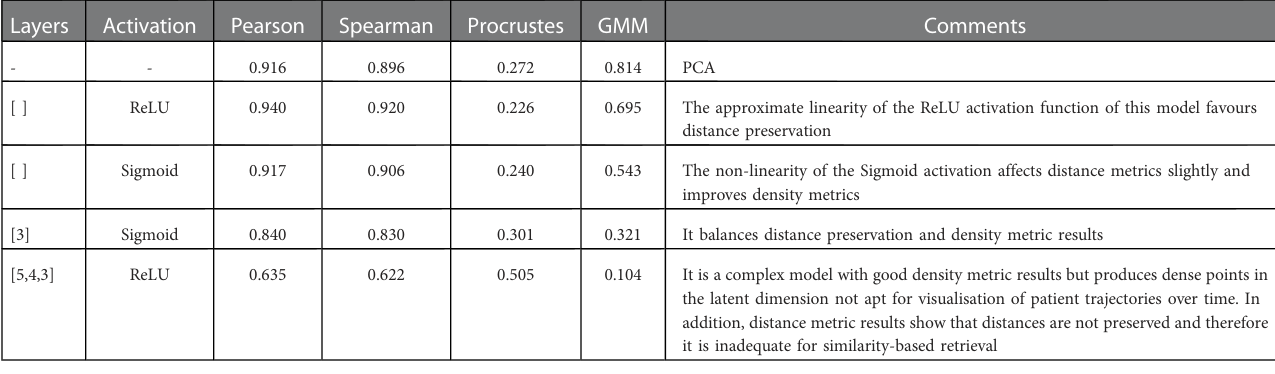
TABLE 7 Evaluation metrics for various representative hyperparameter con fi